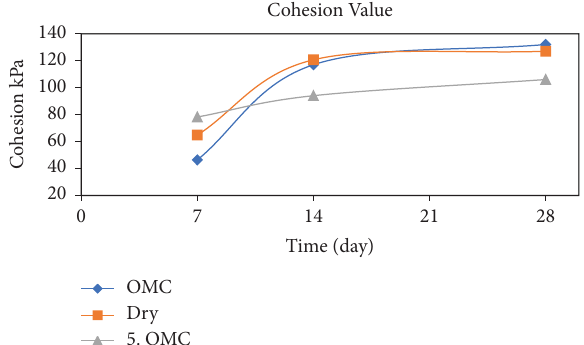
Figure 4: Relationship between the cohesion and the curing time after remolding.